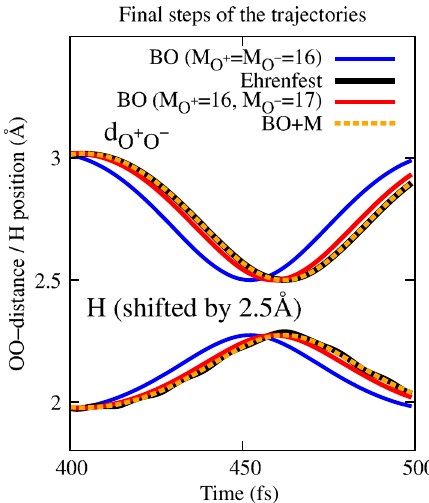
and M indicate the O þ O −